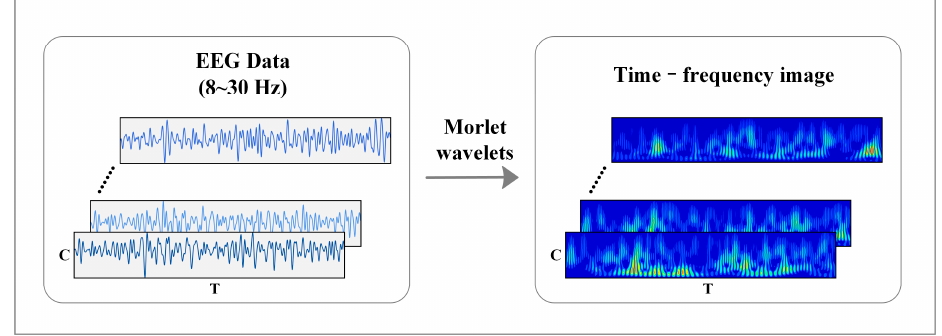
Figure 3. Feature representation of time–frequency image in MI-EEG.